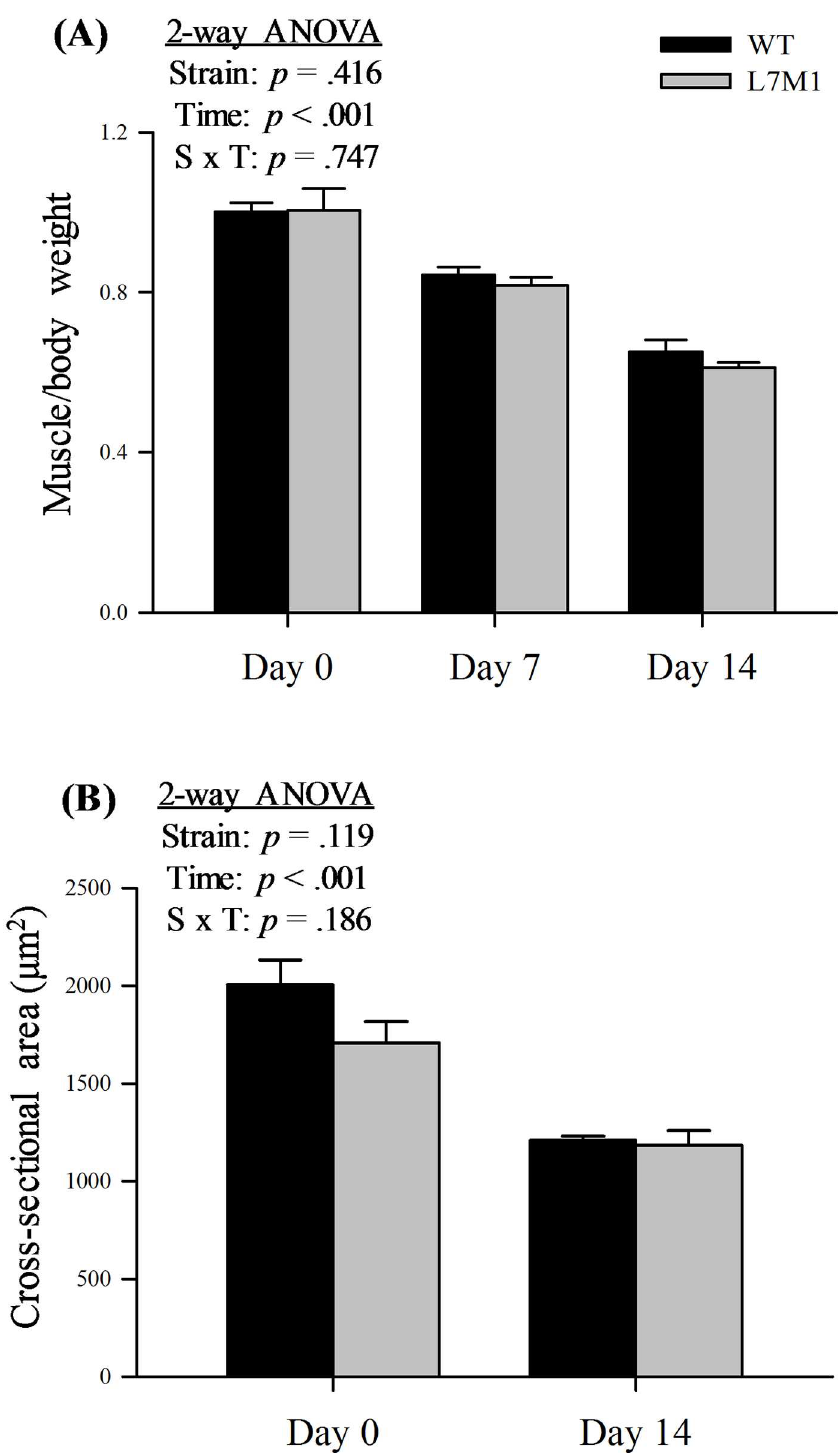
Fig 2. Atrophy of the GAS muscle and single fibers in WT and L7M1 mice. Two-way ANOVA was used to detect the effect of strain (WT vs. L7M1) and time (Day 0, 7, and 14). (A) Results of muscle/body weight are expressedrelativeto the WT Day 0. (B) CSA of individualfibers in GAS muscle (expressed as μ m 2 ). Statistical comparisonshoweda significantdenervation (time) effect in both muscle/body weight and CSA ( p < .001). No strain effect or interaction was detected in any of these measures. Valuesare mean ± SE.